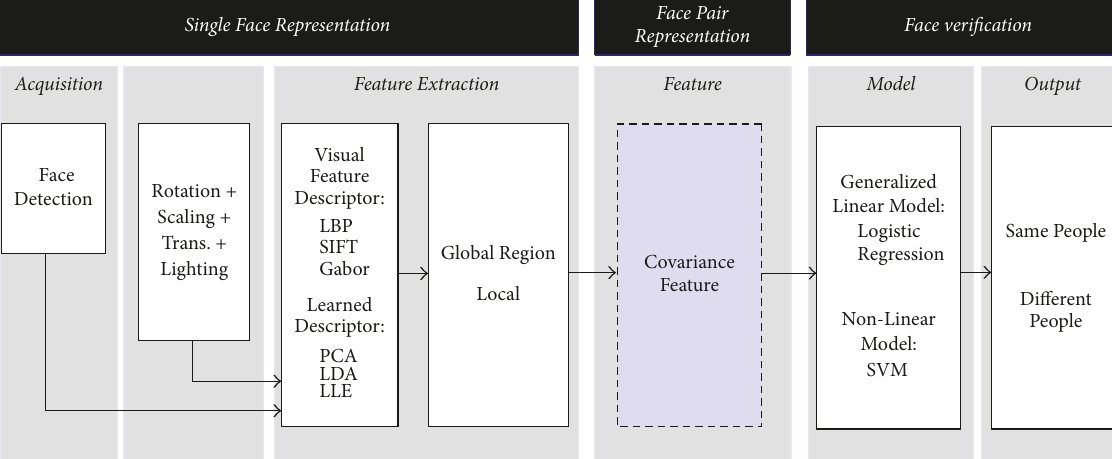
9 sets are used for training. This will generate 10 sets of testing scores. The estimated averaged accuracy and standard devia- tion are computed following the standard definition in